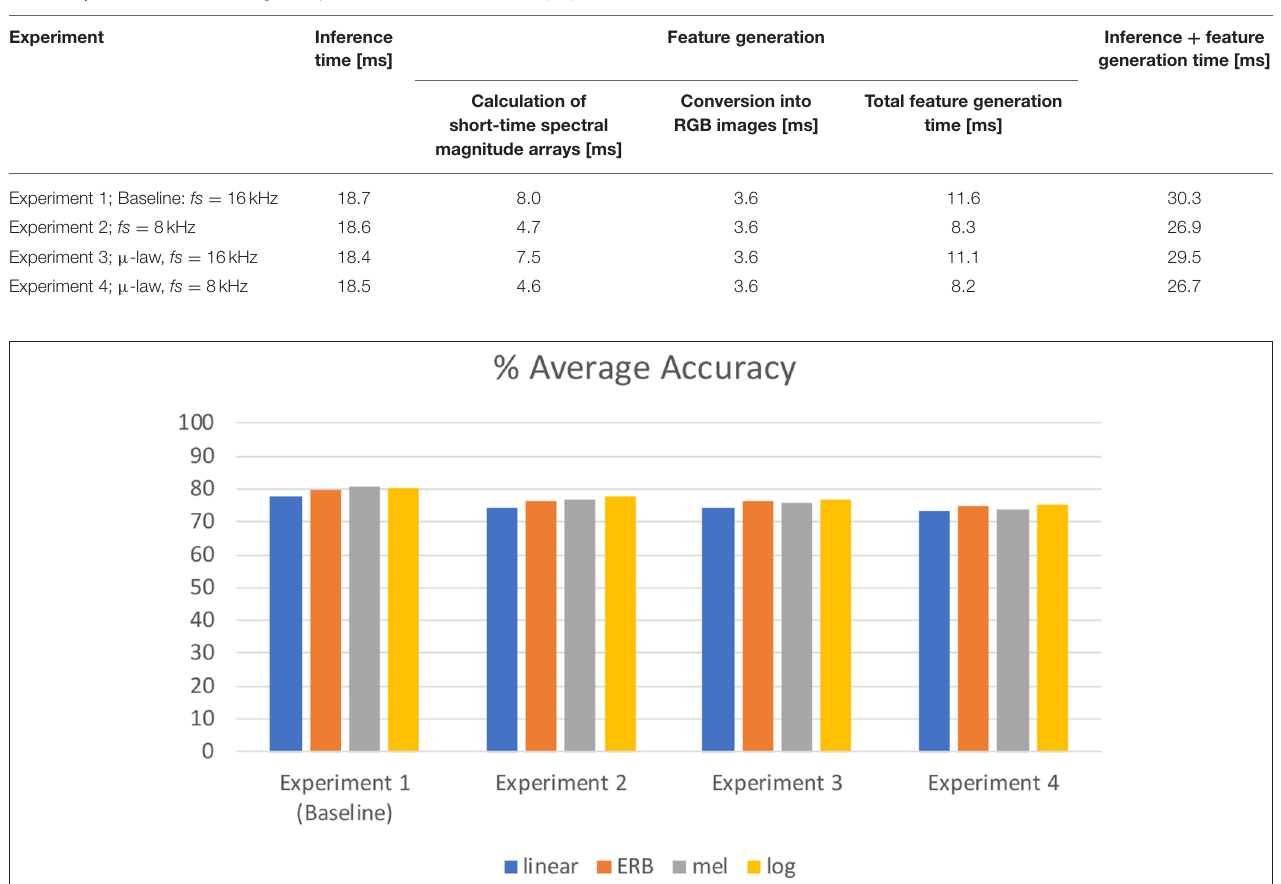
TABLE 7 | Real-time SER—Average computation times in milliseconds (ms).